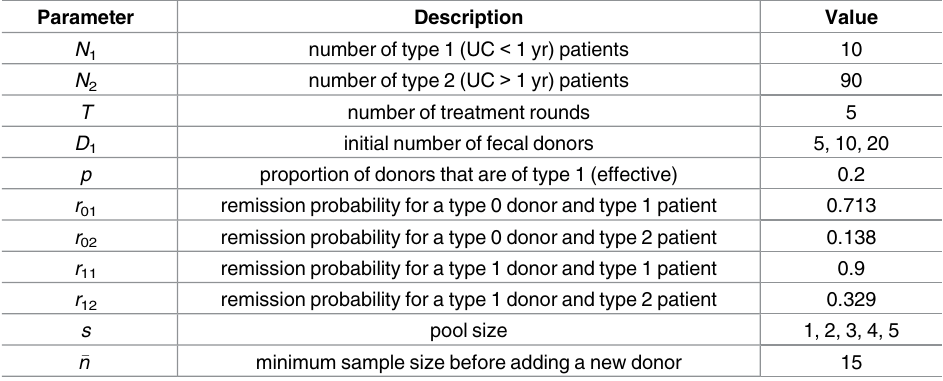
Table 1. The model’s parameters, along with their descriptions and values. Parameter Description Value N 1 T number of treatment rounds D 1 initial number of fecal donors 5, 10, 20 p proportion of donors that are of type 1 (effective)